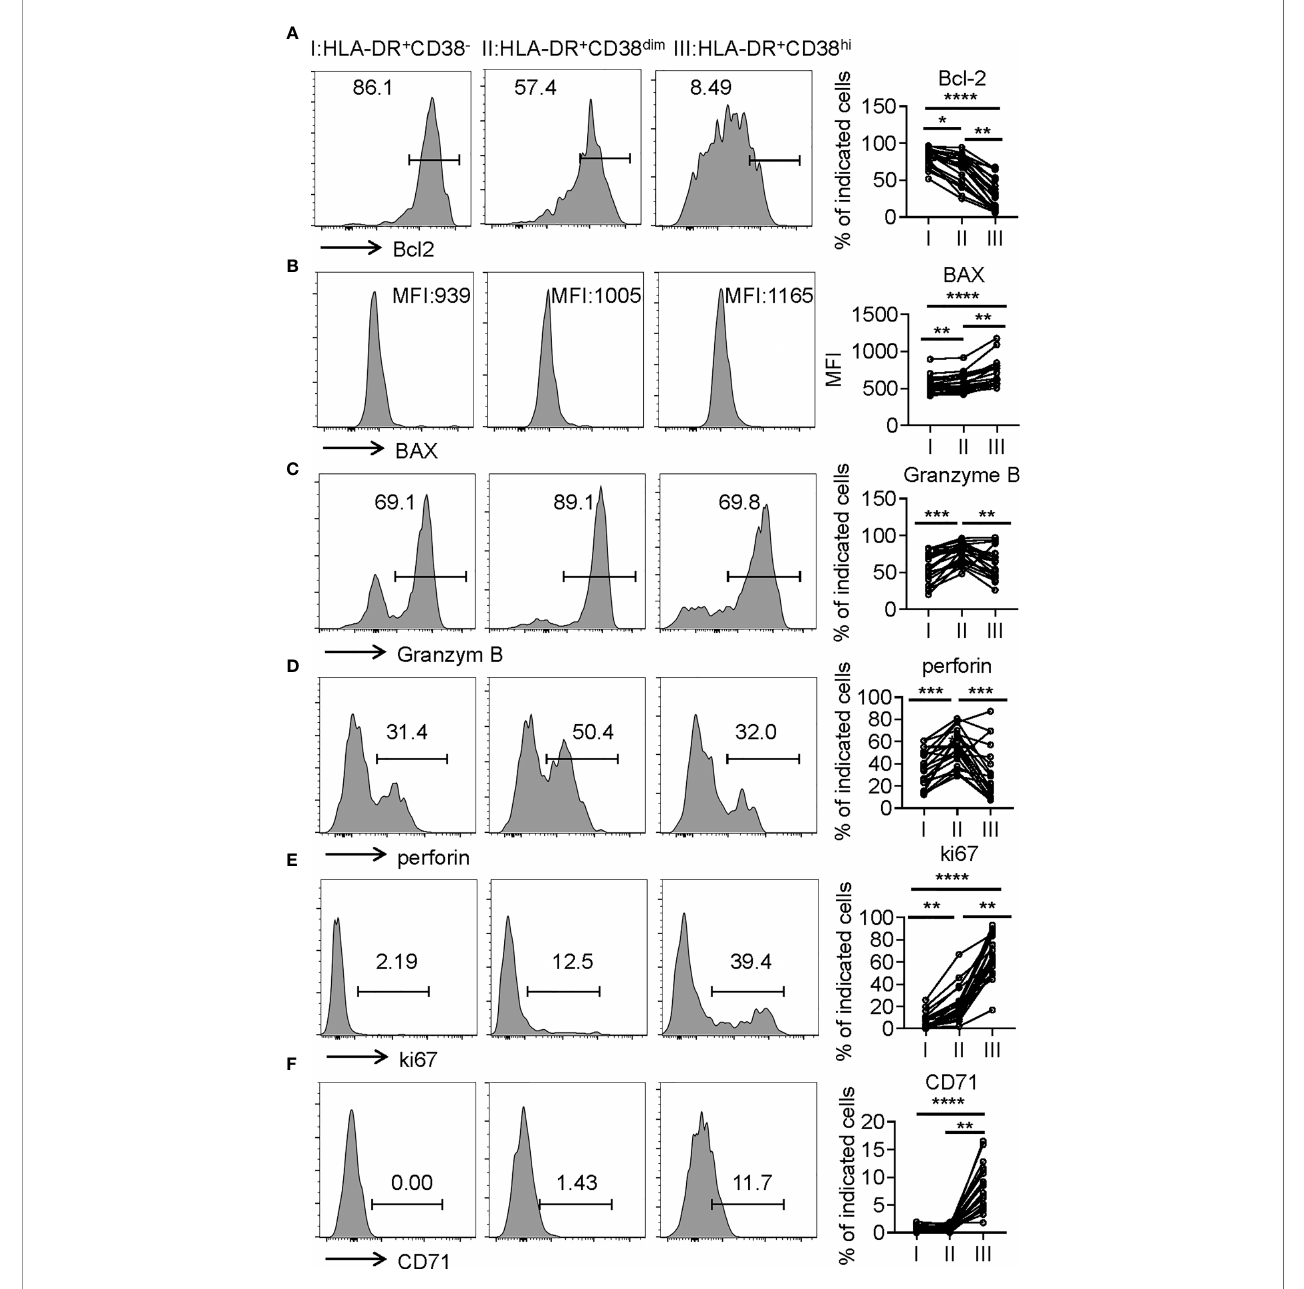
FIGURE 5 | HLA-DR + CD38 hi CD8 + T cells exhibited enhanced susceptibility to apoptosis and highly proliferative potential. Flow cytometry analysis of the expression of Bcl-2 (A) , BAX (B) , Granzyme B (C) , perforin (D) , ki67 (E) , and CD71 (F) on the three CD8 + T population (I, II, III) from patients with infection of COVID-19 (n = 20). Representative histograms (left) and plots (right) display the expression of the above receptors on I, II, III. P Values were obtained by paired two-tailed Student ’ s t tests and repeated measures by one-way ANOVA test followed by Holm-Sidak ’ s multiple comparisons test. *p < .05, **p < .01, ***p < .001, ****p <